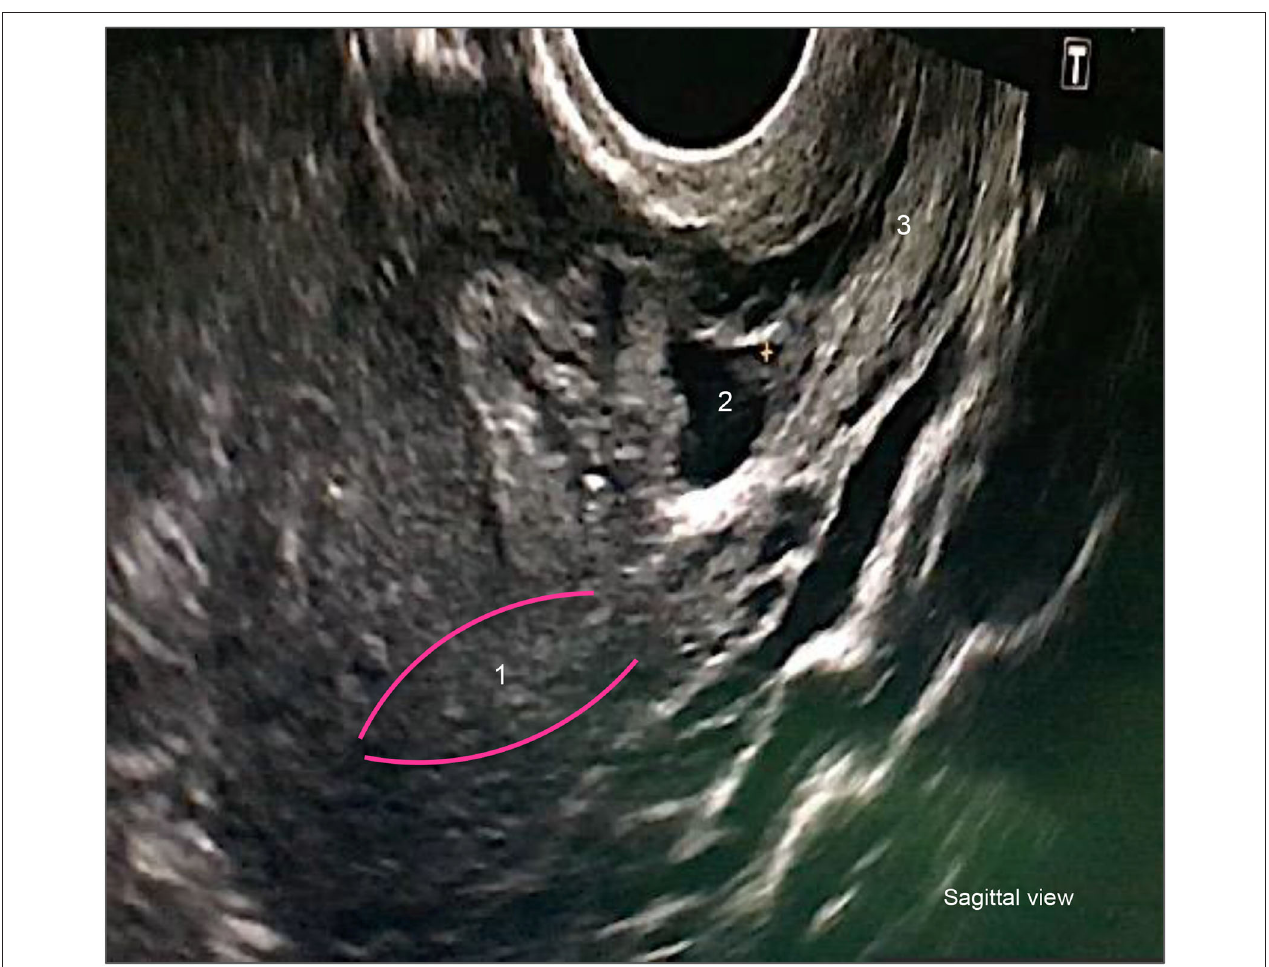
FIGURE 1 | Cesarean scar pregnancy—Sonography. 1. Uterine cavity. 2. Cesarean scar pregnancy.